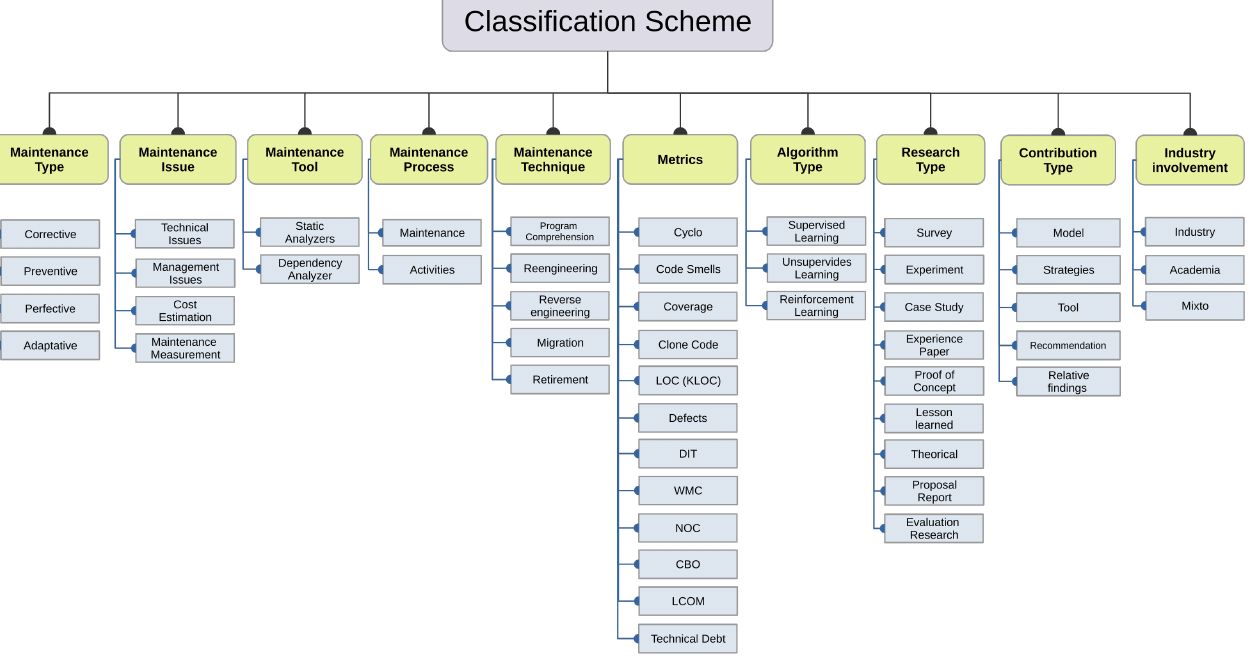
Figure 4. Article classification